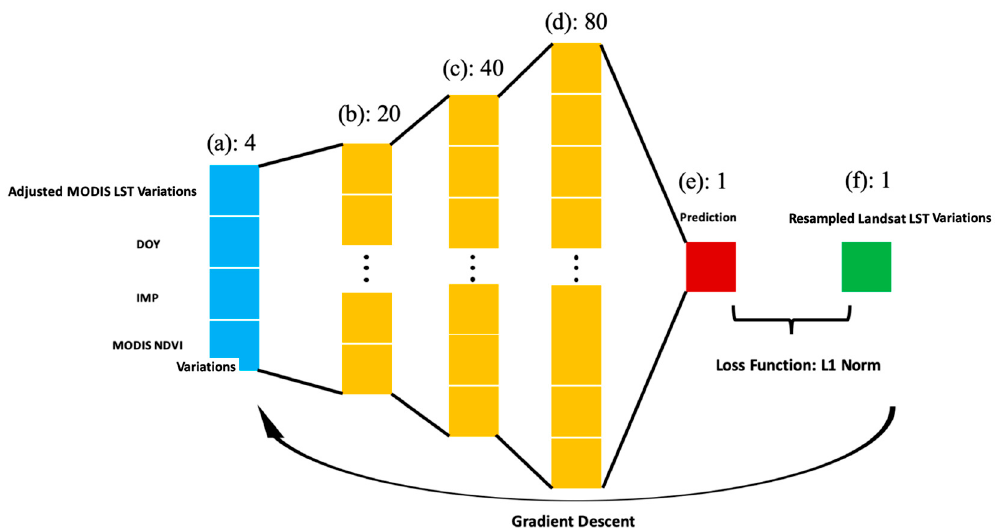
Figure 6. Architecture of the neural network to improve the MODIS LST intra-scene variations. Layer a: 4-dimensional input layer; layer b: 20-dimensional hidden layer; layer c: 40-dimensional hidden layer; layer d: 80-dimensional hidden layer; layer e: one-dimensional output layer; panel f: resampled Landsat LST Variations.